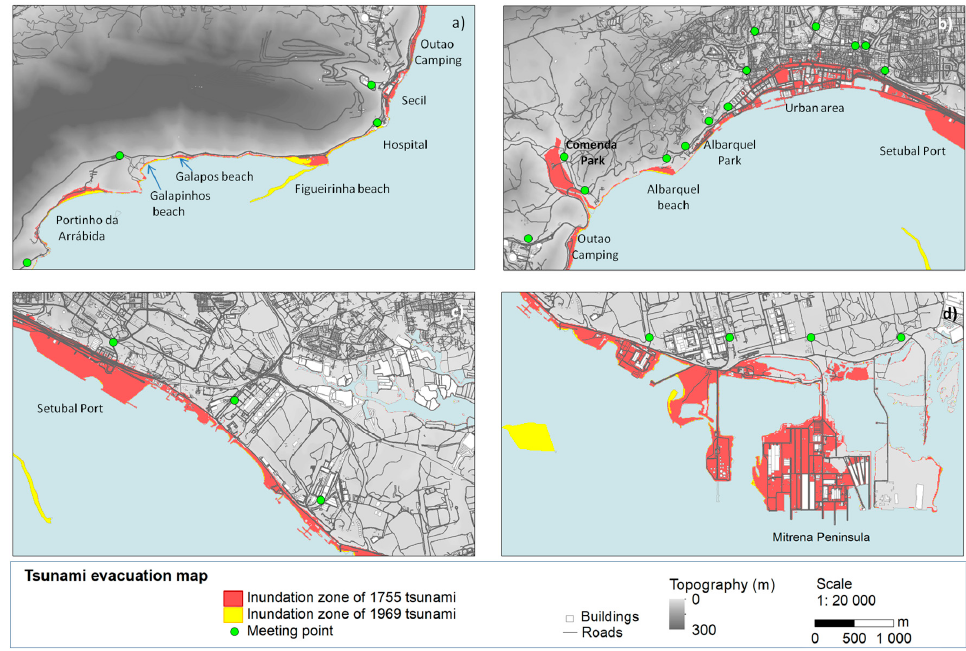
Figure 15. Tsunami evacuation map: ( a ) Western area; ( b ) Central area, including the urban area; ( c ) Eastern area, including the industrial area; ( d ) South-east area where the Mitrena Peninsula is located.